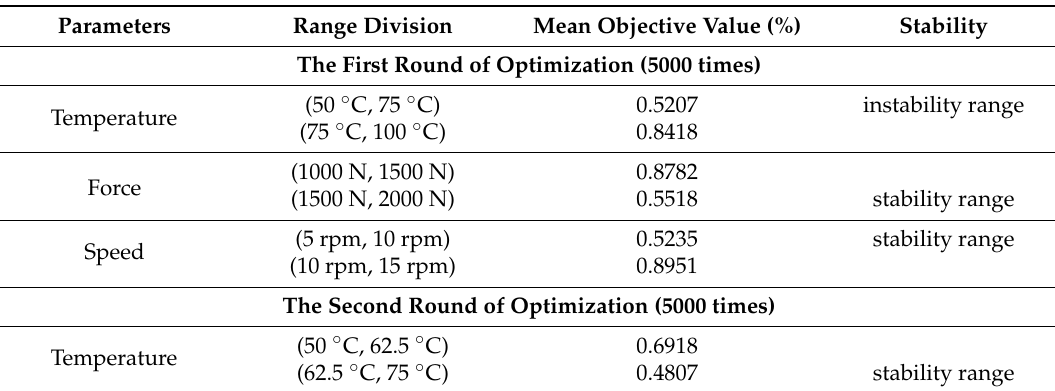
Table 6. Optimization of the tape winding process parameters of the void content model.